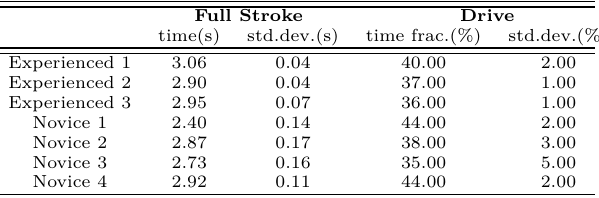
Table 2: Stroke timing consistency for 20